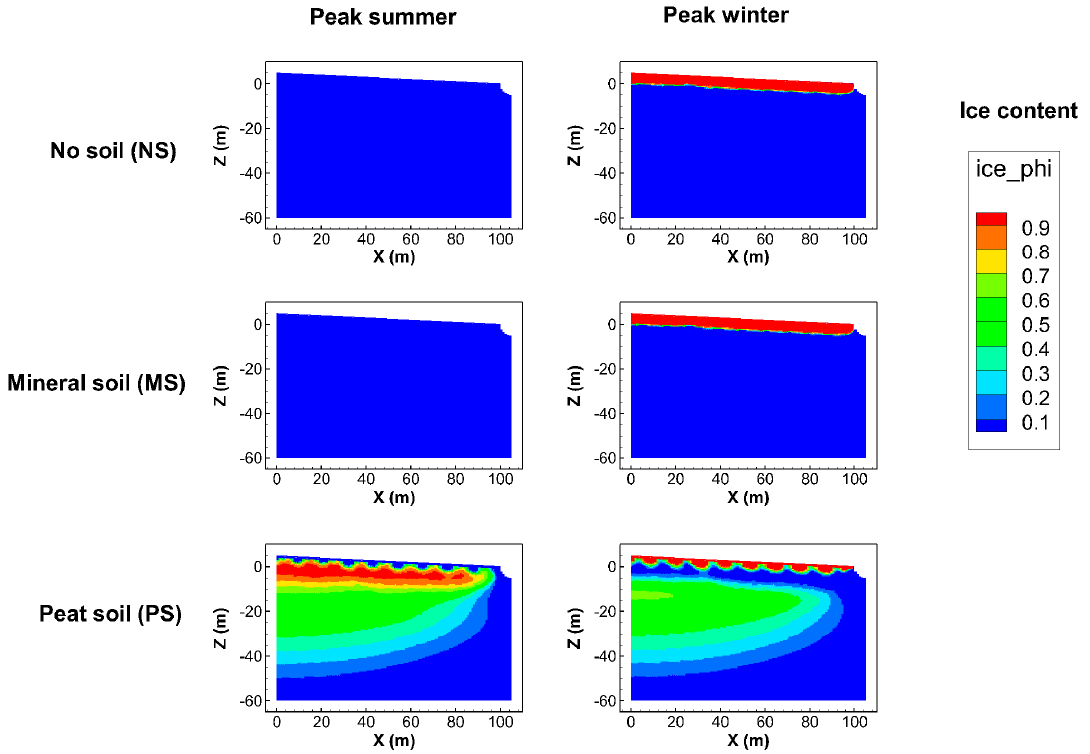
Figure 4. Resulting ice-content conditions for the simulation cases of no soil (NS), mineral soil (MS), and peat soil (PS) in peak summer ( left ) and peak winter ( right ) after a 2 °C increase in surface temperature over 100 years.